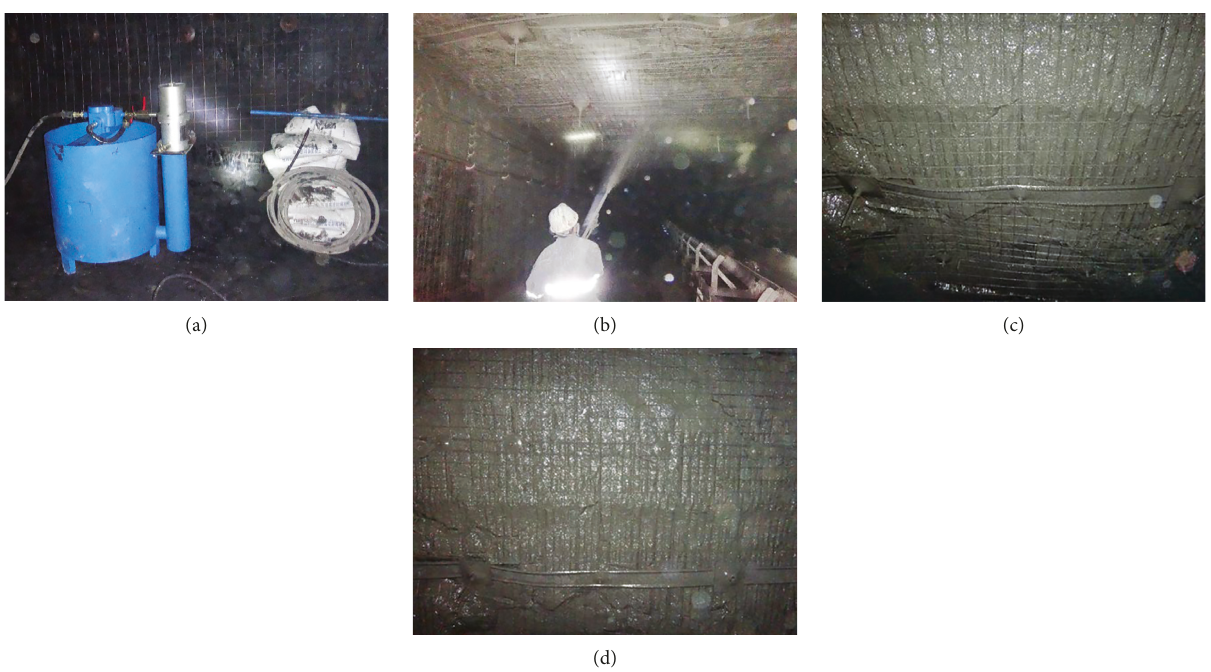
Figure 10: Slurry spraying equipment and construction effects. (a) Slurry spraying equipment. (b) On-site construction drawings. (c) Initial spray shape. (d) Final spray